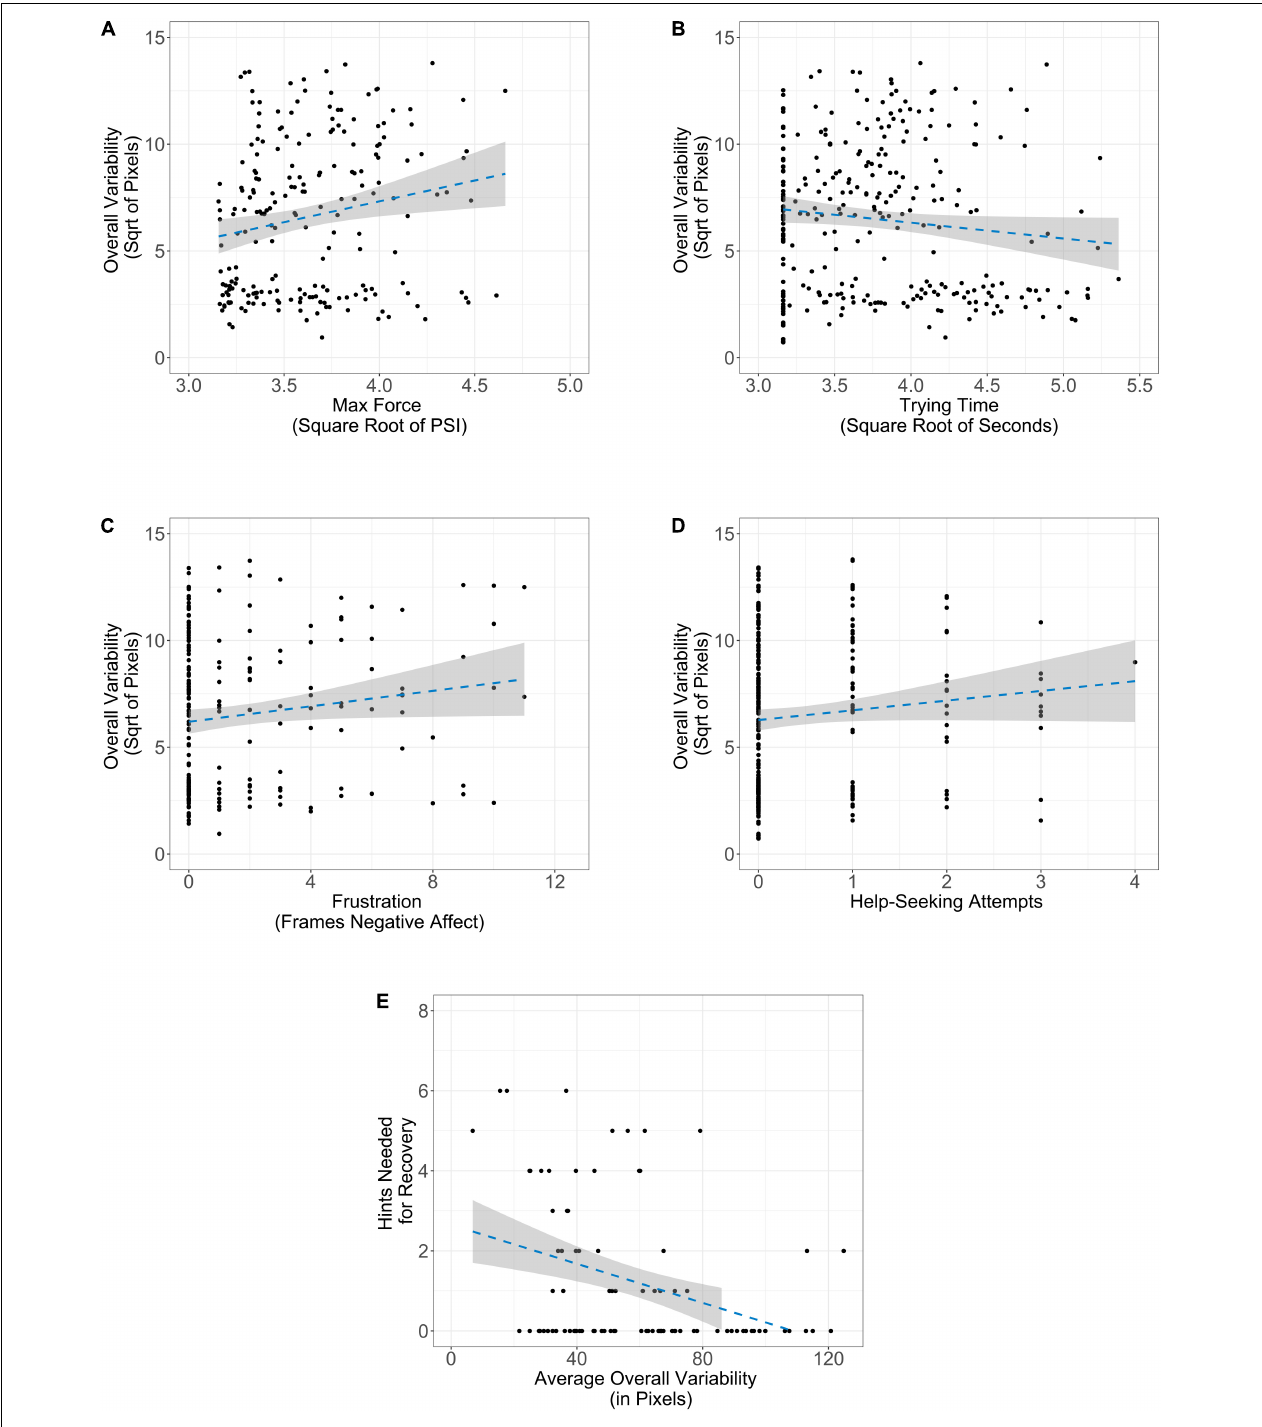
FIGURE 5 | Relationship between performance measures and overall spatial variability: (A) maximum pulling force, (B) trying time, (C) negative affect, (D) help-seeking, and (E) hints during recovery. The shaded region along the line of best fit represents standard error.